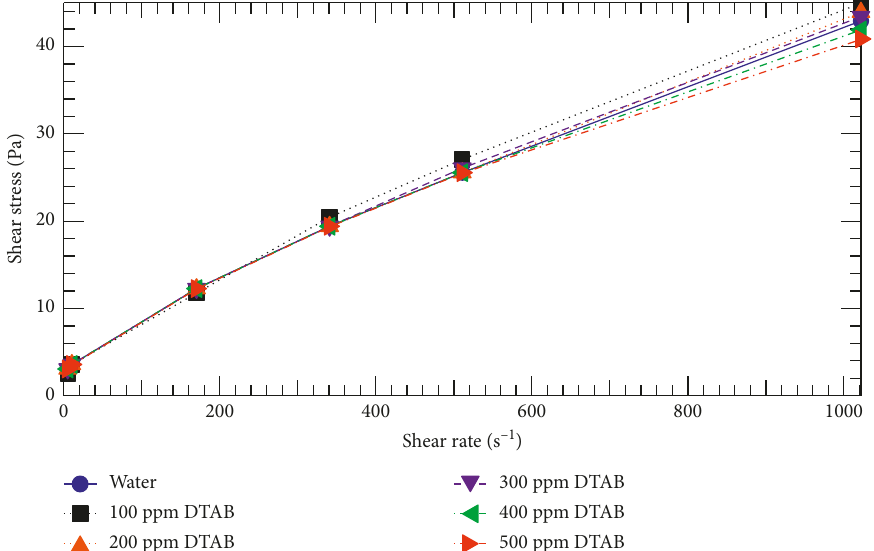
Figure 8: Rheogram of water-based drilling fluid with 0.1 ppb of graphene nanoplatelets dispersed using